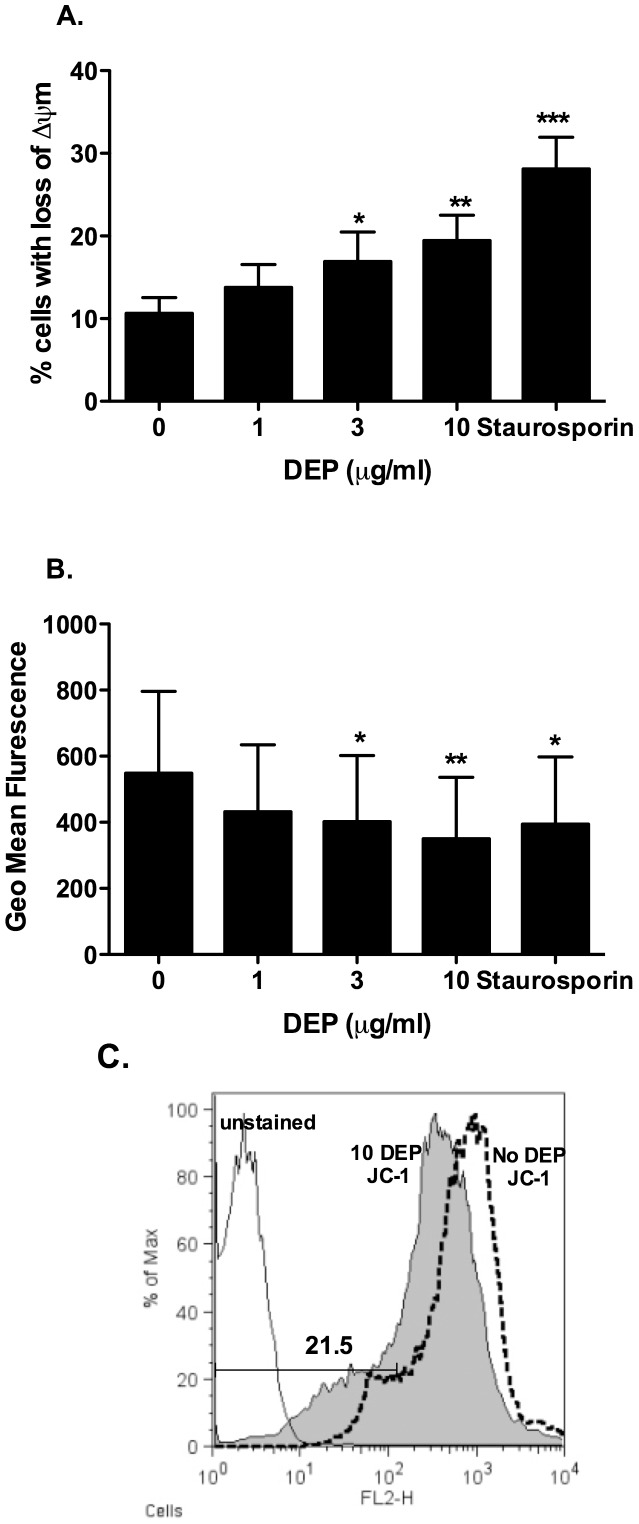
MDMs differentiated in the presence of DEP showed loss of mitochondrial membrane potential (ΔΨm).MDMs were differentiated from purified monocytes in the presence or absence of varied concentrations of DEP as described in the methods. At day 14 MDMs and DEP-MDMs from healthy volunteers were washed three times in PBS. Cells were stained with 10 µM JC-1 in serum free RPMI 1640 for 30 minutes at 37°C. The cells were harvested and resuspended in ice cold PBS for analysis by flow cytometry. Loss of Δψm was detected using a FACSCalibur flow cytometer and was indicated by a decrease in red fluorescence (FL-2). Viable MDMs were identified based on size and granularity on the forward and side scatter plots and ten thousand events were recorded. Data were presented as percentage of cells showing loss of red staining compared to control cells (A) and geomean fluorescence (B) and data analysis was performed using FlowJo software. Figure C shows a representative histogram flow analysis plot from one donor. Data shown are mean±SEM of n = 4–5, performed on different donors with significant differences denoted by *p<0.05, **p<0.01 and ***p<0.001, compared to MDMs differentiated in the absence of DEP, as measured by one way ANOVA and Dunnett’s post test.